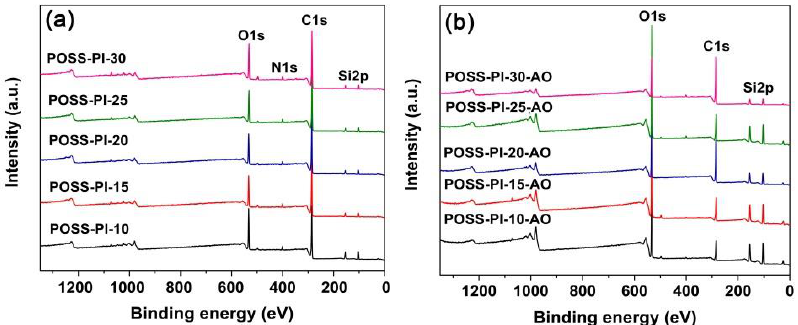
Figure 10. AO erosion yields as a function of DABA-POSS contents for the POSS-PI composite films (Insert: Appearance and field emission scanning electron microscopy (FE-SEM) images of